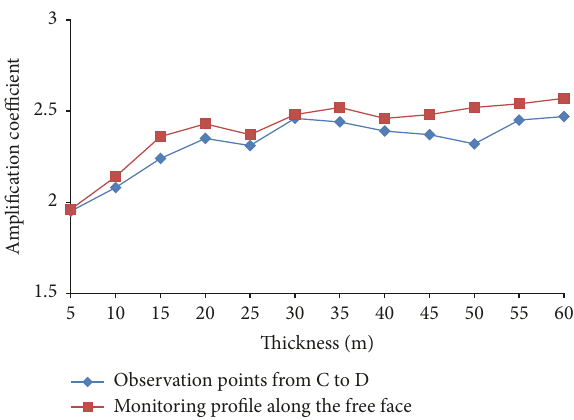
Figure 10: The comparison of amplification